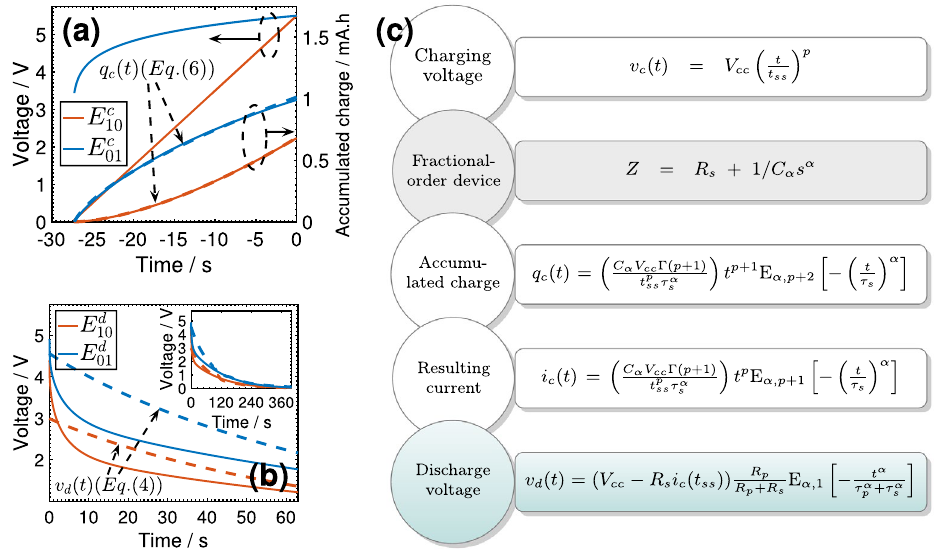
Figure 3. ( a ) Supercapacitor charging using the voltage waveforms v c ( t ) = V cc ( t / t ss ) p with t ss = 27s and E c p = 1.0 and 0.1 (i.e. E c 10 and 01 ) and the resulting time-charge profiles. (b) Illustrates the corresponding discharging voltage waveforms (i.e. E d 10 and E d 01 ). Experimental measurements are plotted in solid lines and simulations are represented by dashed lines. ( c ) Flowchart representing the process and equations of the electric variables during charge (i.e. applied voltage, accumulated charge, and corresponding current), and voltage during discharge into a constant resistor (the device is considered. to be a fractional-order supercapacitor of impedance Z = R s + 1 / C α s α and being charged with a voltage function v c ( t ) = V cc ( t / t ss ) p